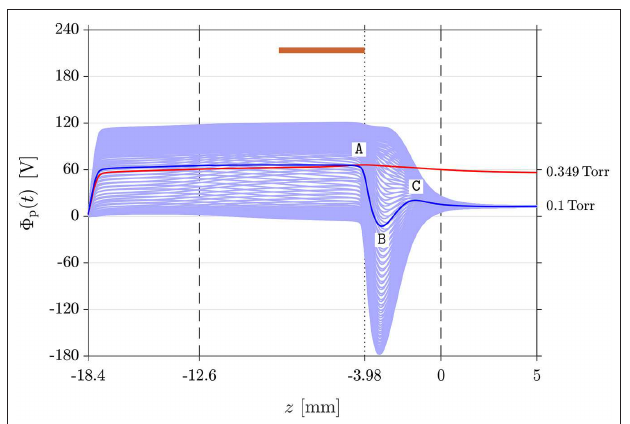
FIGURE 3 | Temporally varying plasma potential 8 p ( t ) (light blue lines) and cycle average 8 p (blue solid line) along the z -axis for the 0.1Torr outlet pressure DL simulation. Points A , B , and C correspond to the DL upper edge, lower edge, and the maximum potential of the tail barrier respectively. The red solid line represents 8 p of the 0.349Torr outlet pressure reference simulation (top panel in Figure 1 ). Vertical dashed and dotted lines are defined in Figure 2 .